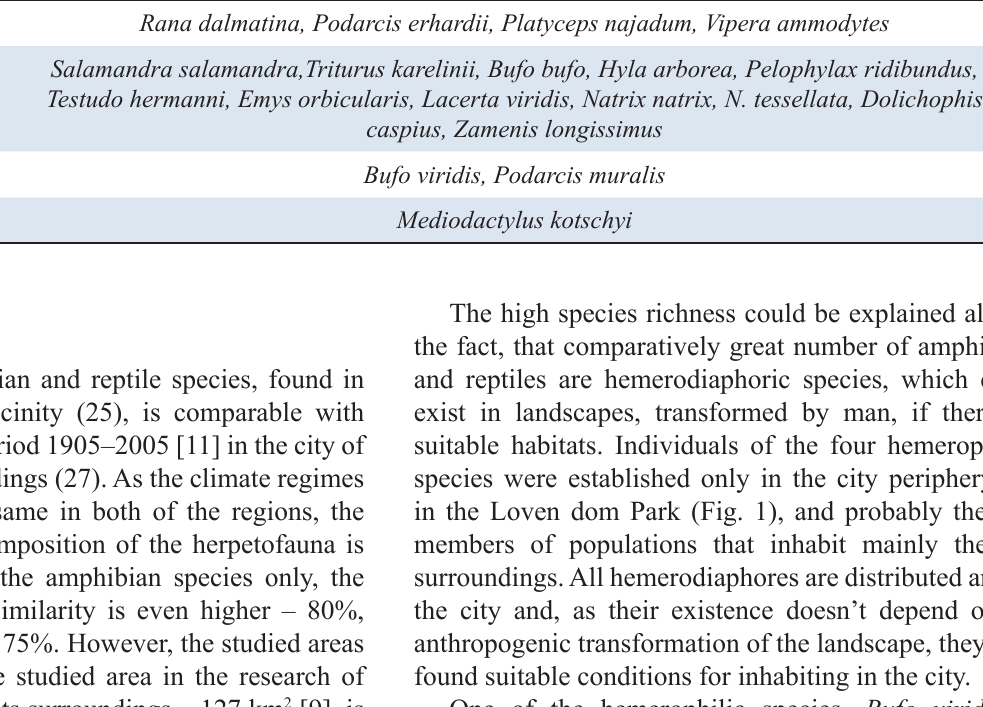
Table 3. Ecological groups of amphibians and reptiles, according to their level of synanthropy. Level of